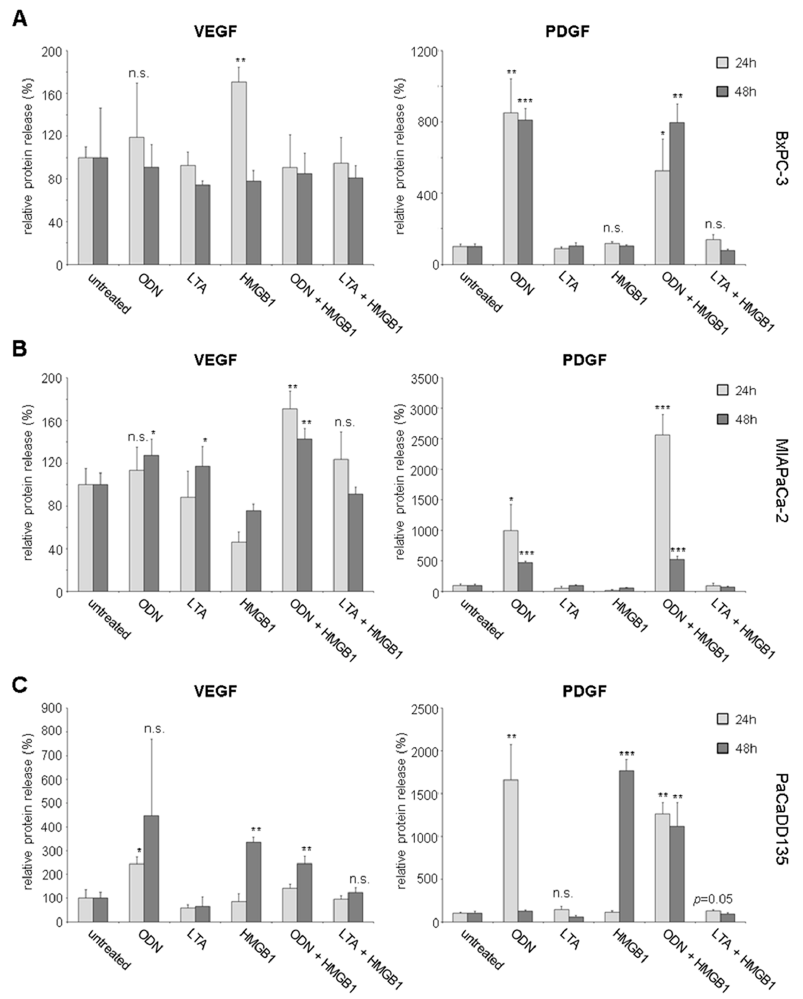
Figure 7. Luminex analysis of VEGF and PDGF expression in supernatants of human pancreatic cancer cells after treatment with TLR ligands: BxPC-3 ( A ); MIAPaCa-2 ( B ); and PaCaDD135 ( C ) were incubated with ODN, LTA, HMGB1, ODN + HMGB1, and LTA + HMGB1 and supernatants were analyzed 24 h and 48 h after stimulation. Untreated cells were standardized to baseline. * p < 0.05, ** p < 0.005, *** p < 0.0001, n.s. not